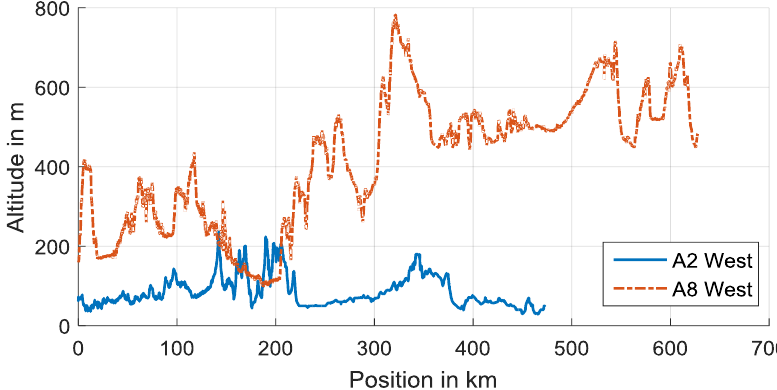
Figure 5. Elevation profiles of German highways A2 and A8 in direction west.